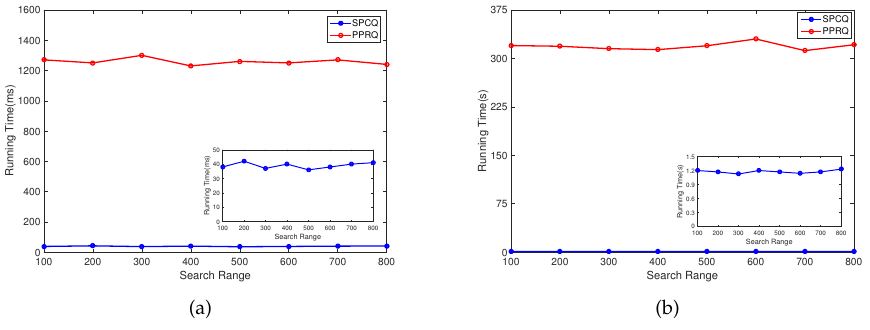
Figure 3. Computational overheads of SPCQ and PPRQ. ( a ) Average running time in DU with different search ranges; ( b ) average running time in CS with different search ranges.